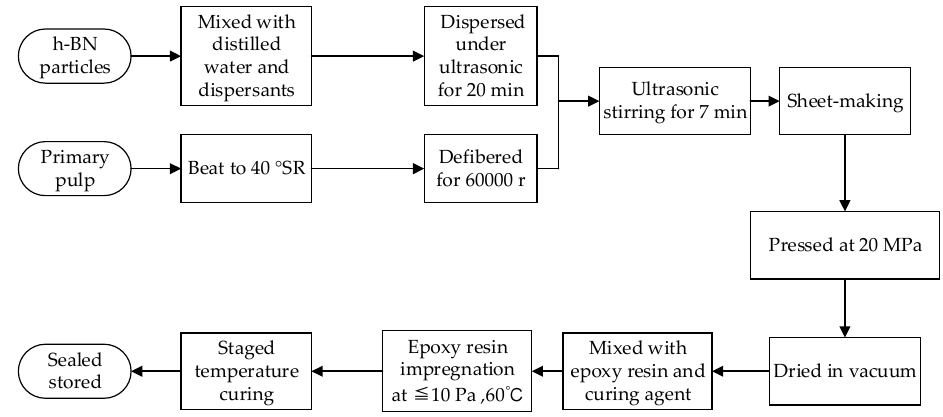
Figure 1. The flow chart of the making process of epoxy resin impregnated nano-h-BN modified pressboard.